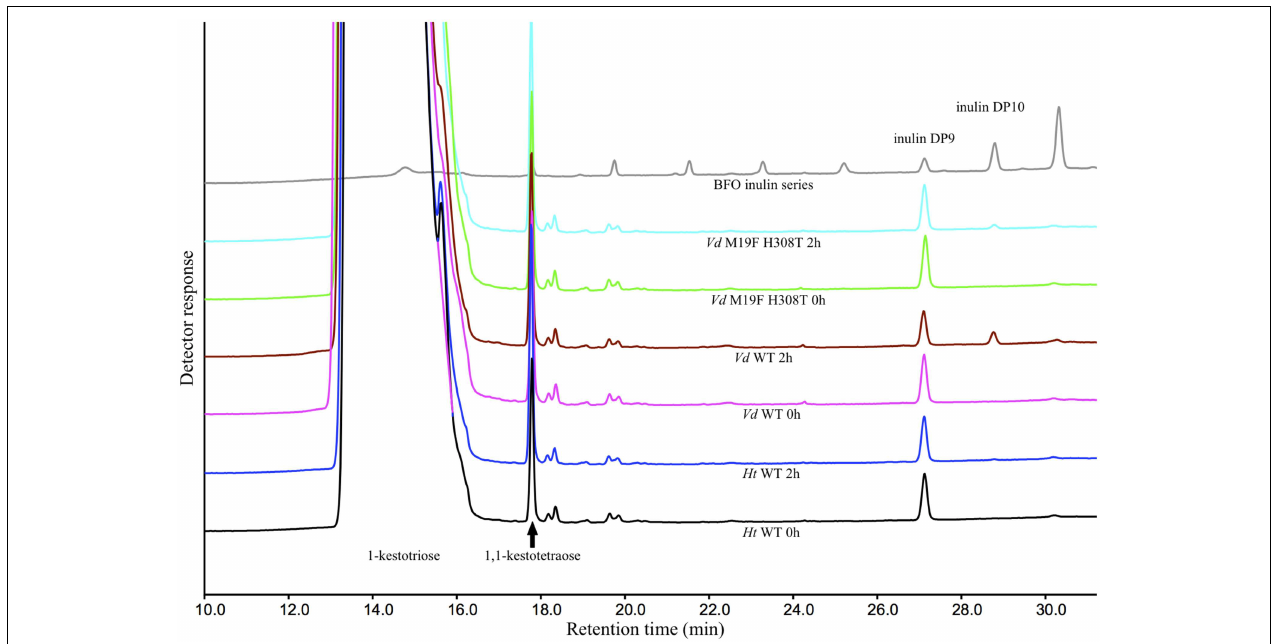
FIGURE 4 | HPAEC-IPAD chromatograms generated by the Ht and Vd WT and the M19F H308T double mutant at time 0 and after 2h of incubation with 1-kestotriose (100mM) and DP9 BFO (80 µ M) as substrate. Also included is a chromatogram of a BFO series ranging from 1-kestotriose (DP3) to DP11.